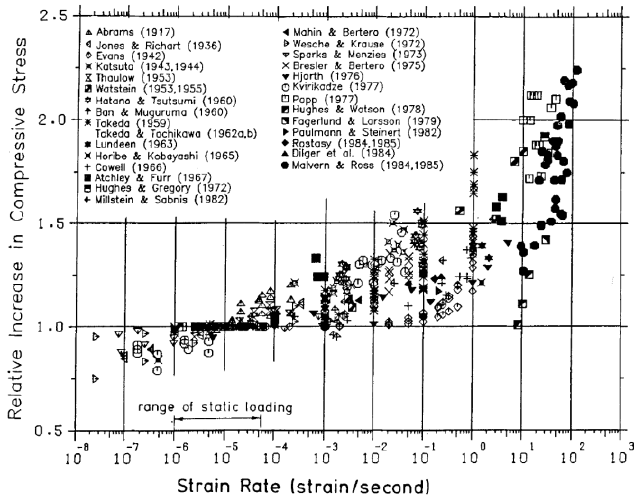
Figure 5. Influence of the strain rate on the compressive strength of concretes [37 – 66].